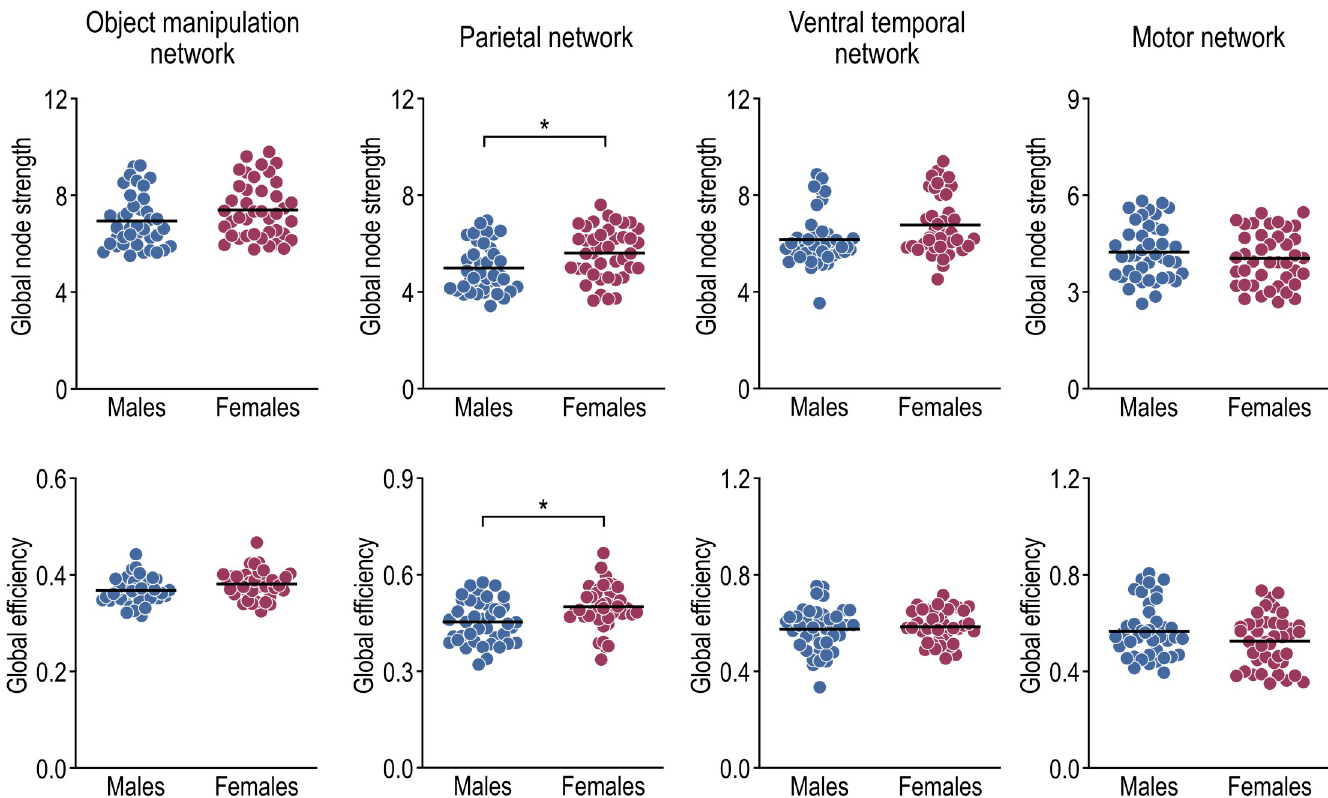
Fig 3. Global node strength and global efficiency of structural networks in the object manipulation, parietal, ventral temporal, and motor networks. � p < 0.05.